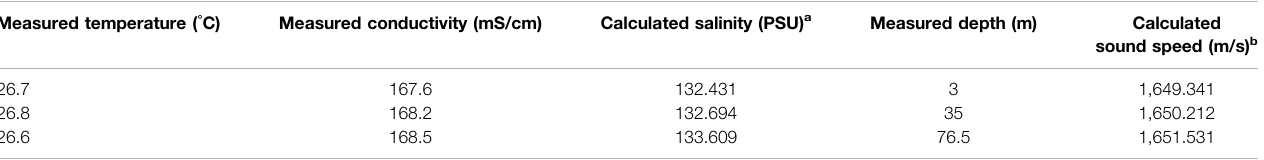
TABLE 1 | Depth-correction base